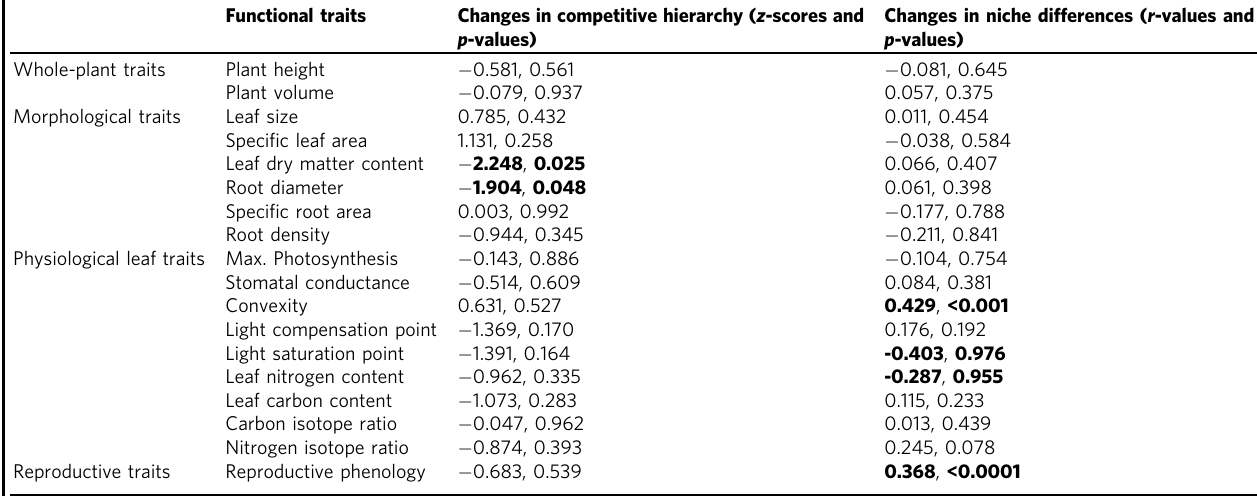
Table 2 Effects of phenotypic plasticity on maintaining competitive dominance and varying niche differences Functional traits Changes in competitive hierarchy ( z -scores and p -values) Whole-plant traits